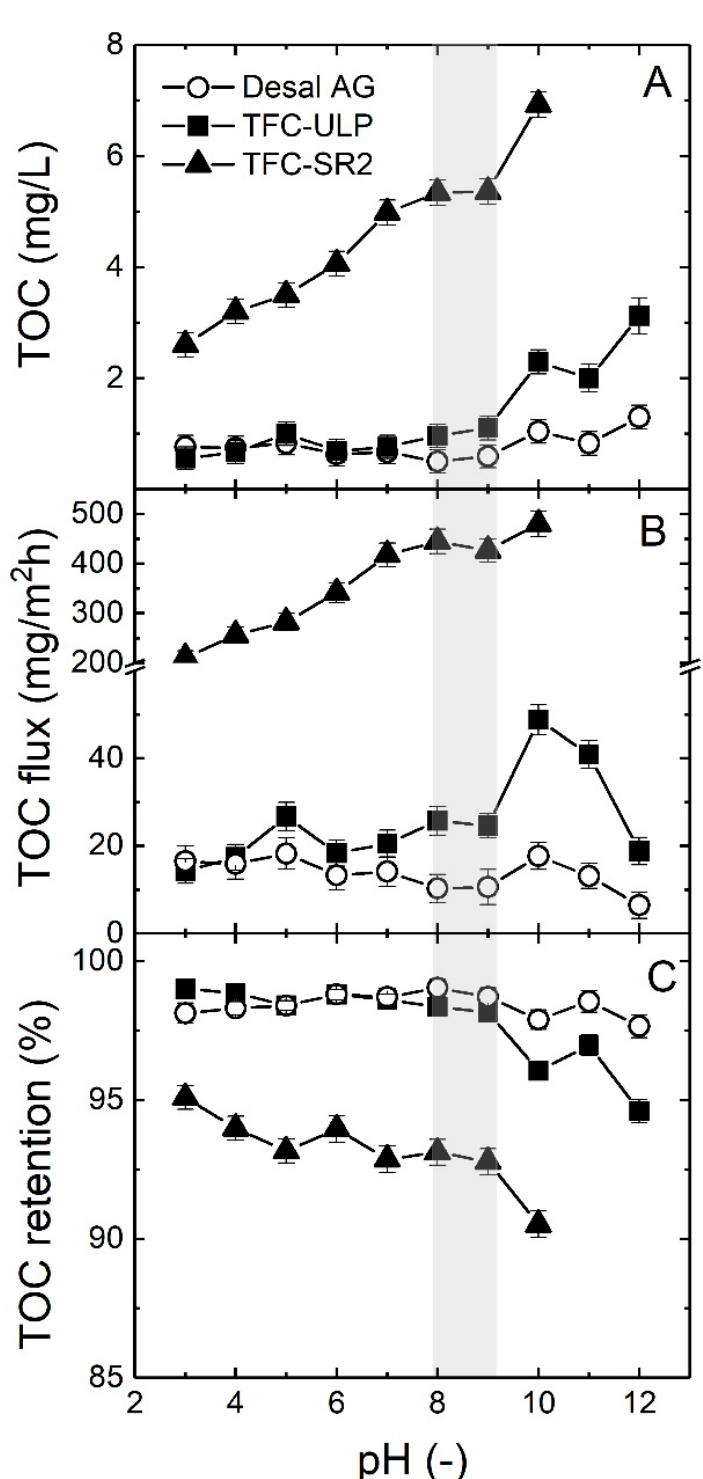
Figure 11. ( A ) TOC permeate concentration, ( B ) TOC flux and ( C ) TOC retention as a function of the pH (3 − 12) of groundwater sample 5. The grey area is TOC removal at the pH range of groundwater samples 1 − 5. The applied pressure was 10 bar. Data adapted from [69].